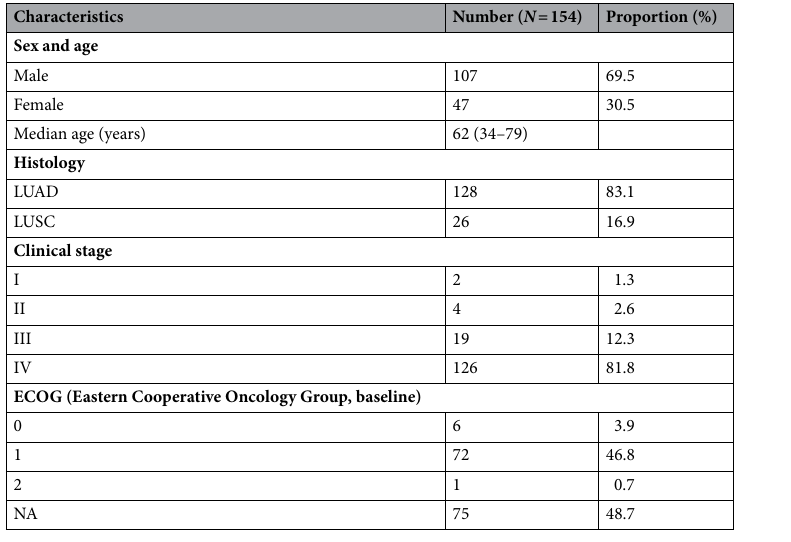
Table 1. Baseline characteristics of